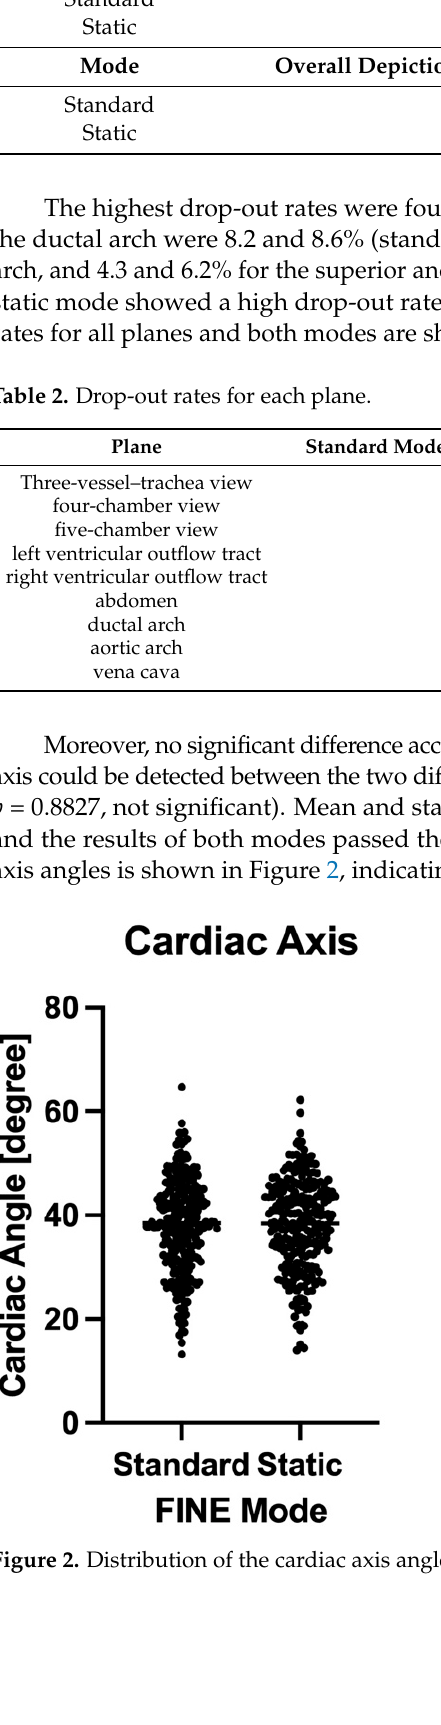
Table 1. Properly displayed planes for both modes.